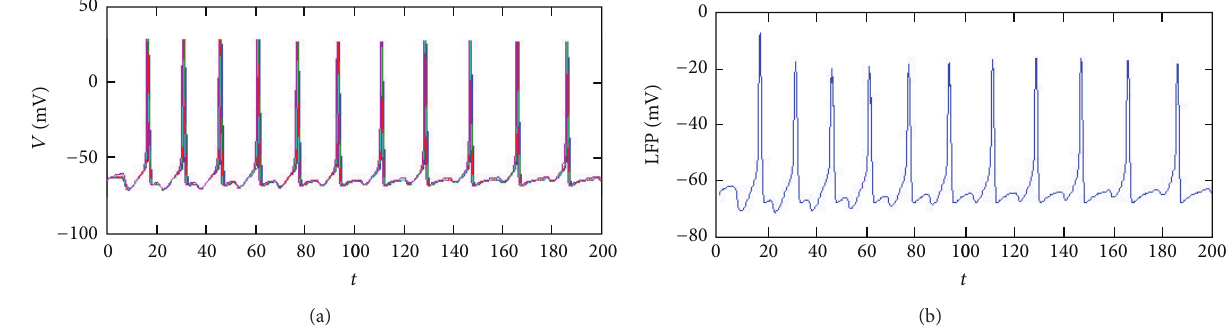
= 0.1 . (b) LFP of five MCs when 𝑔 GABA